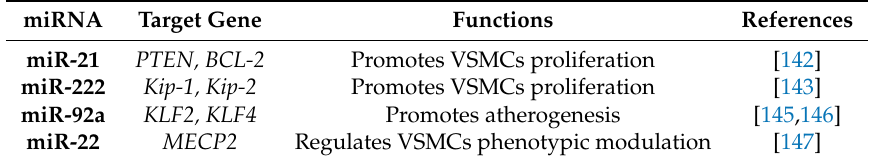
Table 3. Circulating miRNAs involved in the pathological programming of di ff erent vascular